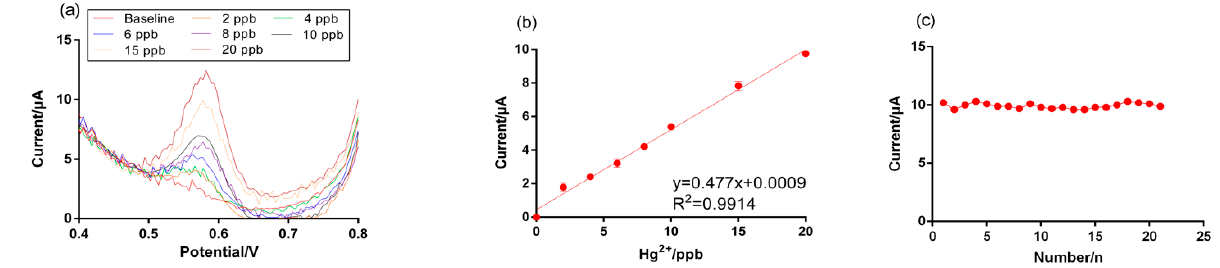
Figure 6. ( a ) SWASV replies for Hg 2+ determination, ( b ) plot of the stripping peak current vs Hg 2+ concentration, and ( c ) reproducibility. Deposition time is 200 s with a − 0.6 V deposition potential, 0.004 V potential step, 0.025 V amplitude, and 60 Hz frequency. Hg 2+ concentration was 20 ppb (0.1M acetate buffer at pH 3.0). The error bars represent the standard deviation for the mean of the three replicate tests. Table 1. Comparison of different types of sensor performance for electrochemical Hg (II) detection. Electrode Sample Condition (Buffer Solution)